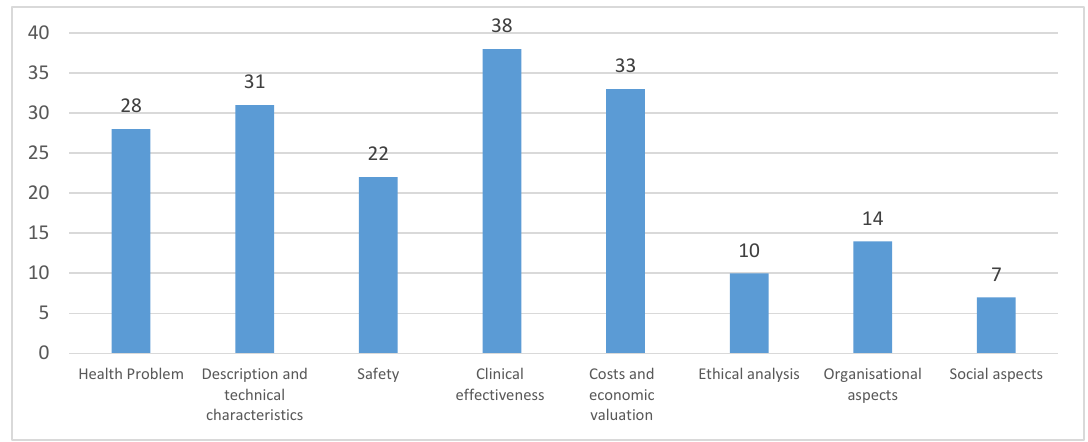
Figure 2. Characteristics of the available forty-five health technology assessment reports on omics